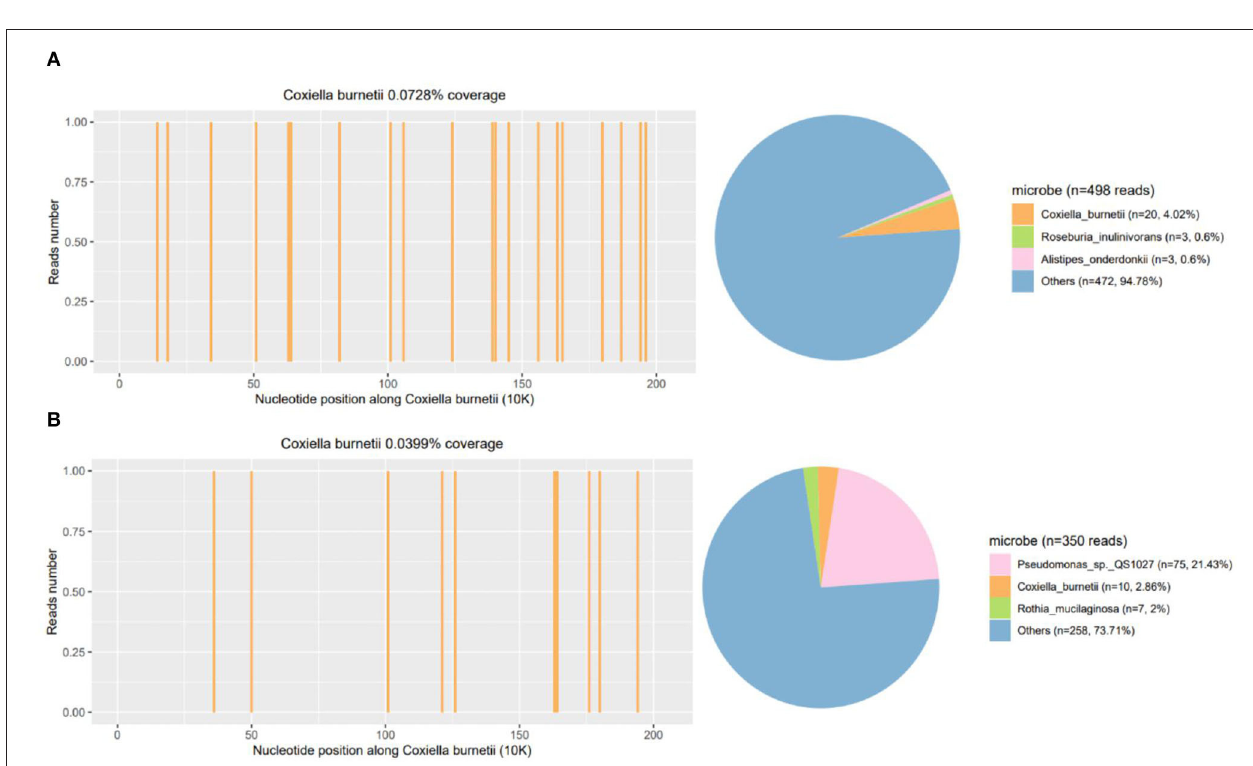
microbiological detection such as culture and serology methods (16). It has a great advantage in the diagnosis of complex and severe infections, such as respiratory tract infection (17, 18), joint infection (19), encephalitis (20), and microbial keratitis and endophthalmitis (21, 22). As a novel pathogen identification